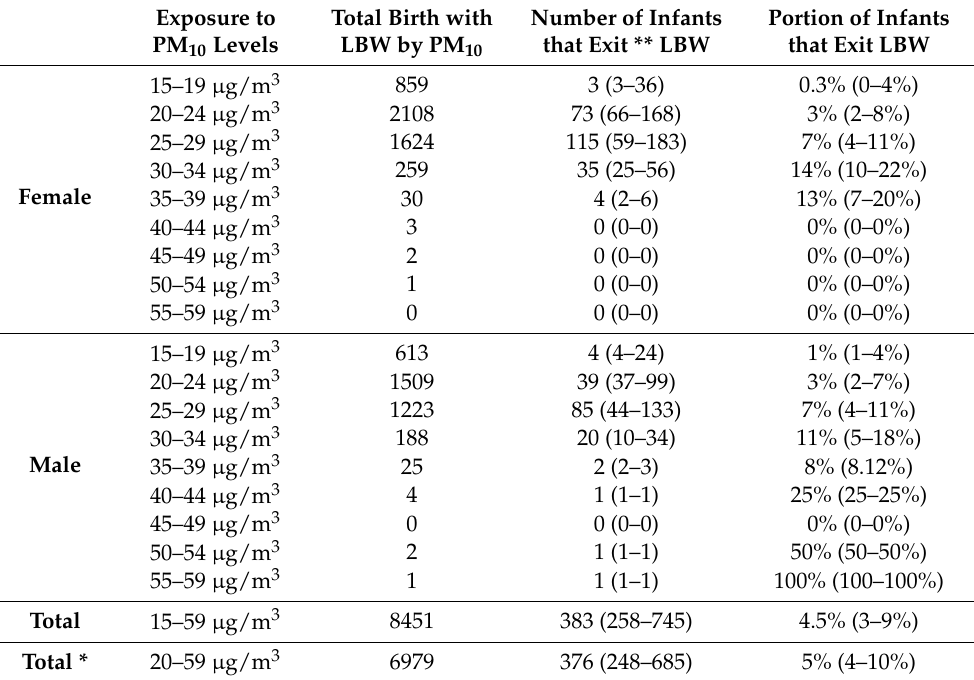
Table 3. LBW by Infant sex and exposure to PM 10 levels with recommendation of WHO to reduce annual PM 10 AQG level to less than 15 µ g/m 3 .